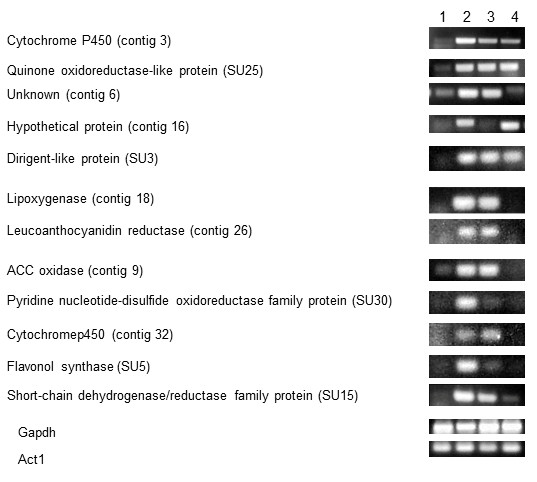
Semi-quantitative RT-PCR analysis of 12 selected up-regulated unigenes. Semi-quantitative RT-PCR was carried out using RNA from the Taxus cuspidata P93AF cell line. RNA samples were taken at 6h, 18h and 5 day after MJ elicitation, and from mock elicited cells at the same time points. Lane 1: Mock elicited for 18h, Lane 2-4: elicited with 100 μM MJ for 6h, 18h or 5 day, respectively. Gapdh and Actin1 were used as normalization controls.